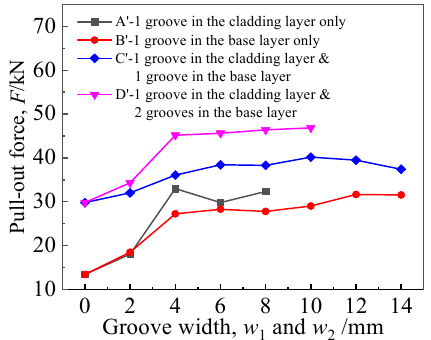
Figure 16. E ff ects of groove width on pullout force. Figure 16. Effects of groove width on pullout